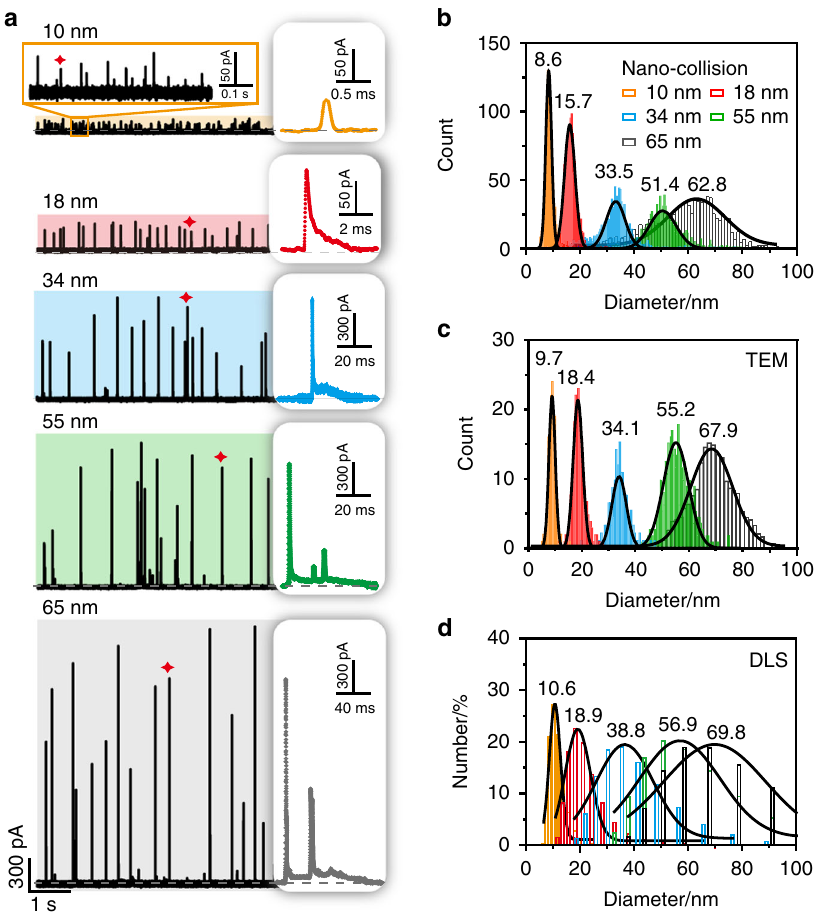
Fig. 3 Electrochemical size measurement of individual AgNPs by surface-con fi ned nano-collision. a Chronoamperometric curves and representative current signals of individual AgNPs with different sizes in diameters of 10, 18, 34, 55 and 65 nm at + 600mV vs. Ag/AgCl wire in alkaline solution at an Au UME (diameter 12.5 μ m), respectively. Size distribution histograms of AgNPs for individual samples of fi ve sizes of NPs measured separately via nano- collision ( b ), TEM ( c ) and DLS ( d ). Source data are provided as a Source Data fi